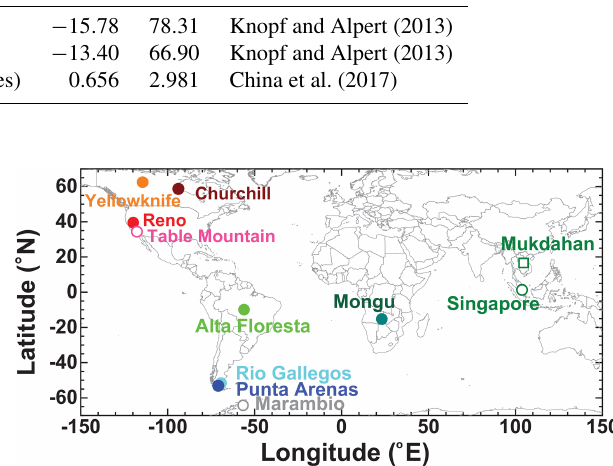
Table 2. Values for b and k for three organic aerosol INP types required to determine the ice nucleation rate J het , I with Eq. (10). INP type b k Reference Pahokee peat (organic substance) Leonardite (organic substance) − 13 . 40 Free-tropospheric aerosol (smoke plumes over Azores)